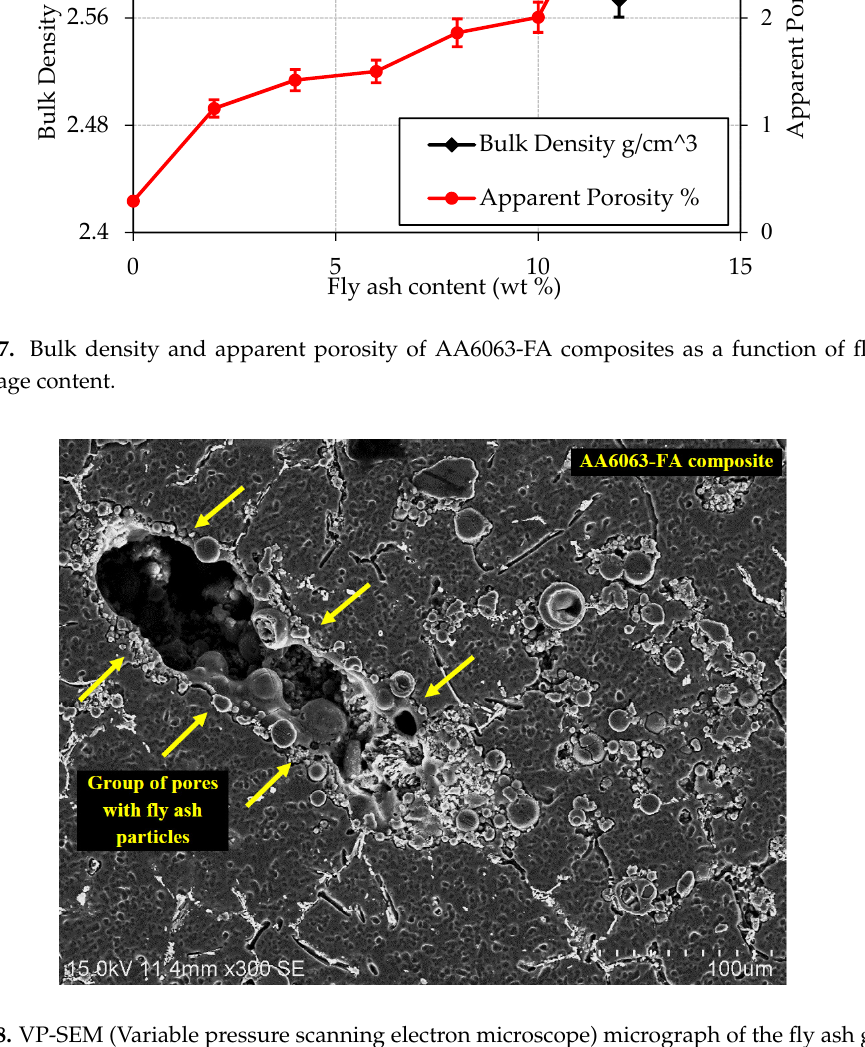
Figure 8. VP ‐ SEM (Variable pressure scanning electron microscope) micrograph of the fly ash grains with group of pores in the surface of AA6063 ‐ FA composite (12 wt % fly ash).